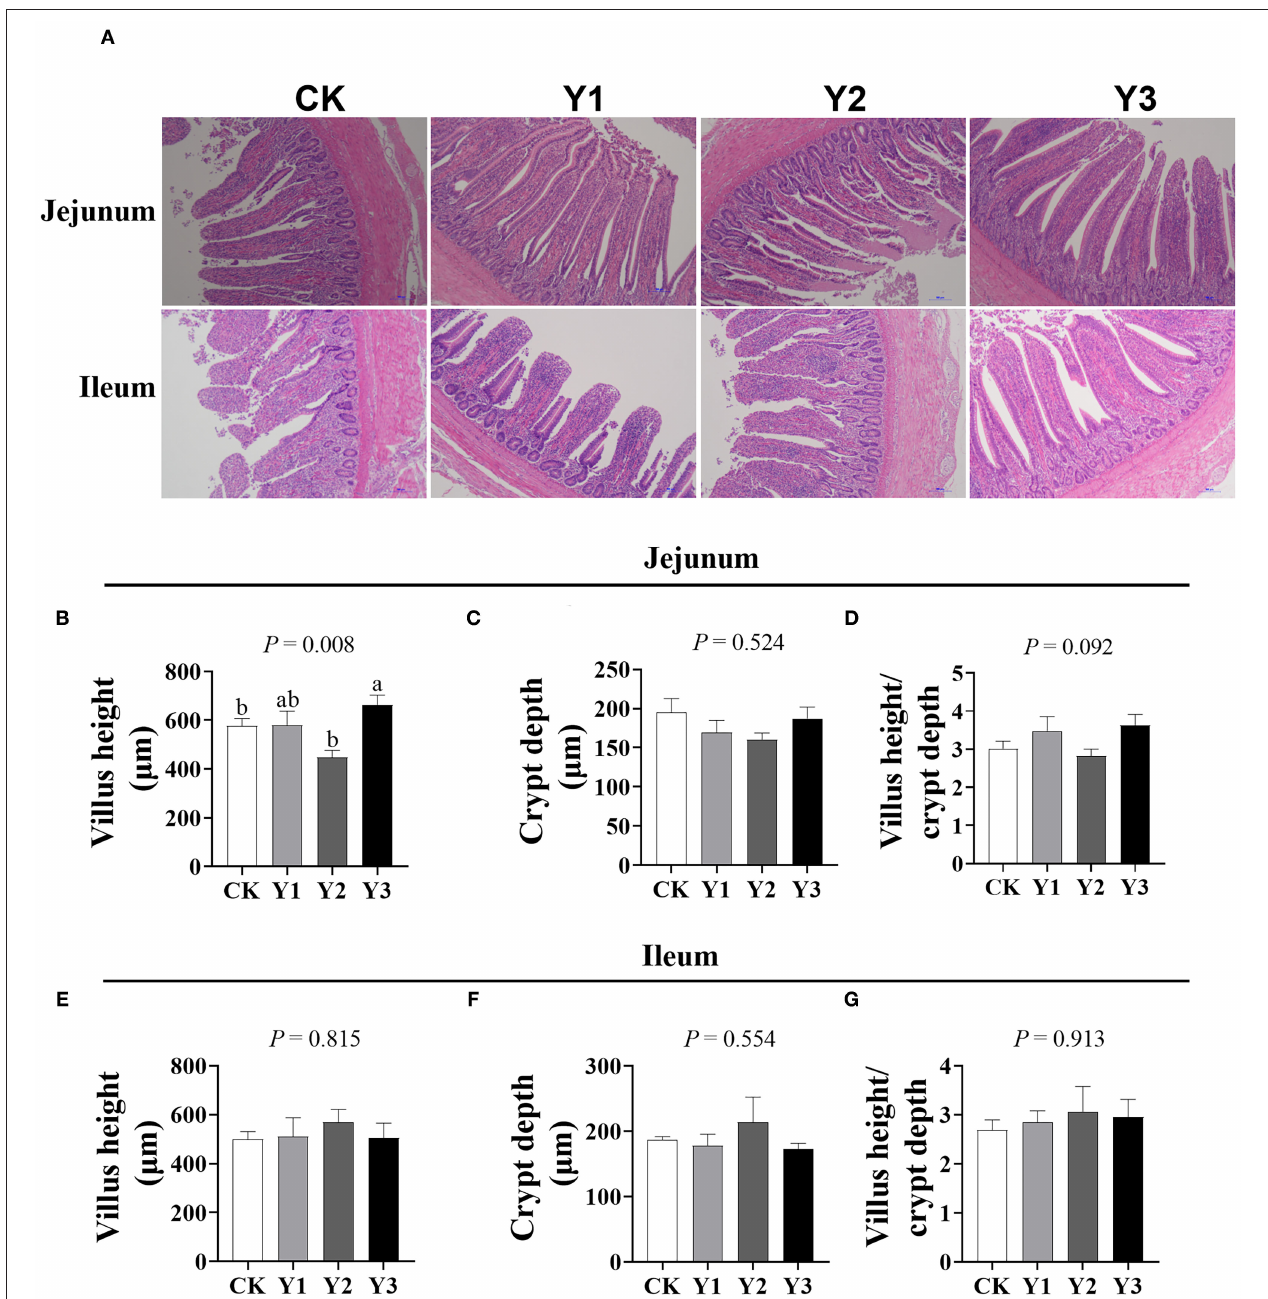
FIGURE 2 | Effects of dietary AOE on intestinal morphology of ducks. (A) The images of the jejunum and ileum morphology, magnification 10 × ; Summarized data of villus height, crypt depth, and the ratio of villus height to crypt depth in jejunum (B–D) and ileum (E–G) .